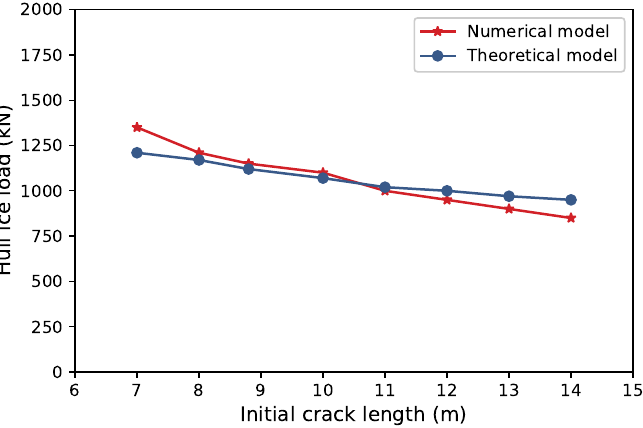
Figure 8. The relationship curve of hull ice load and initial crack